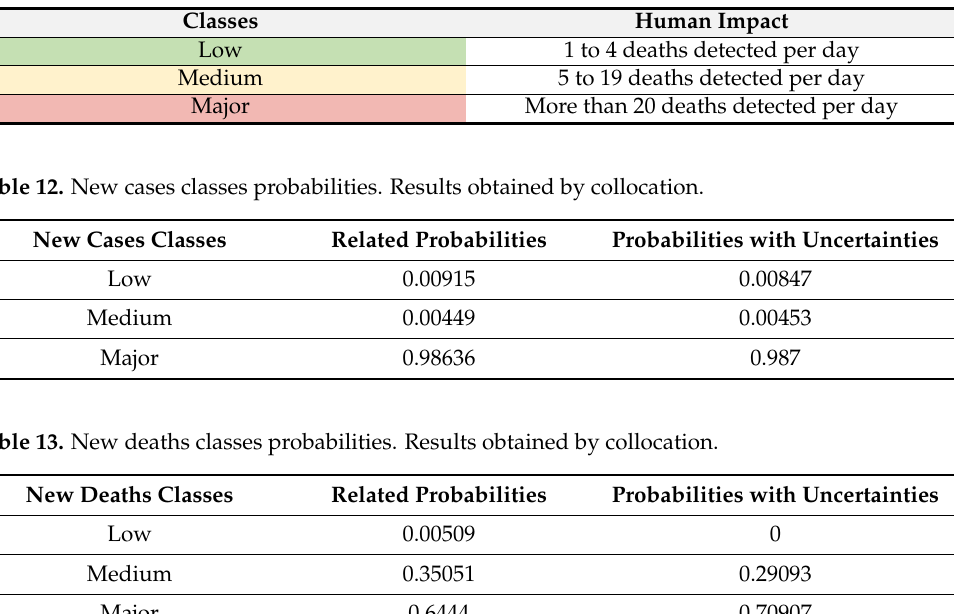
Table 11. Classification of the human impact of SARS-CoV-2 based on new deaths detection.